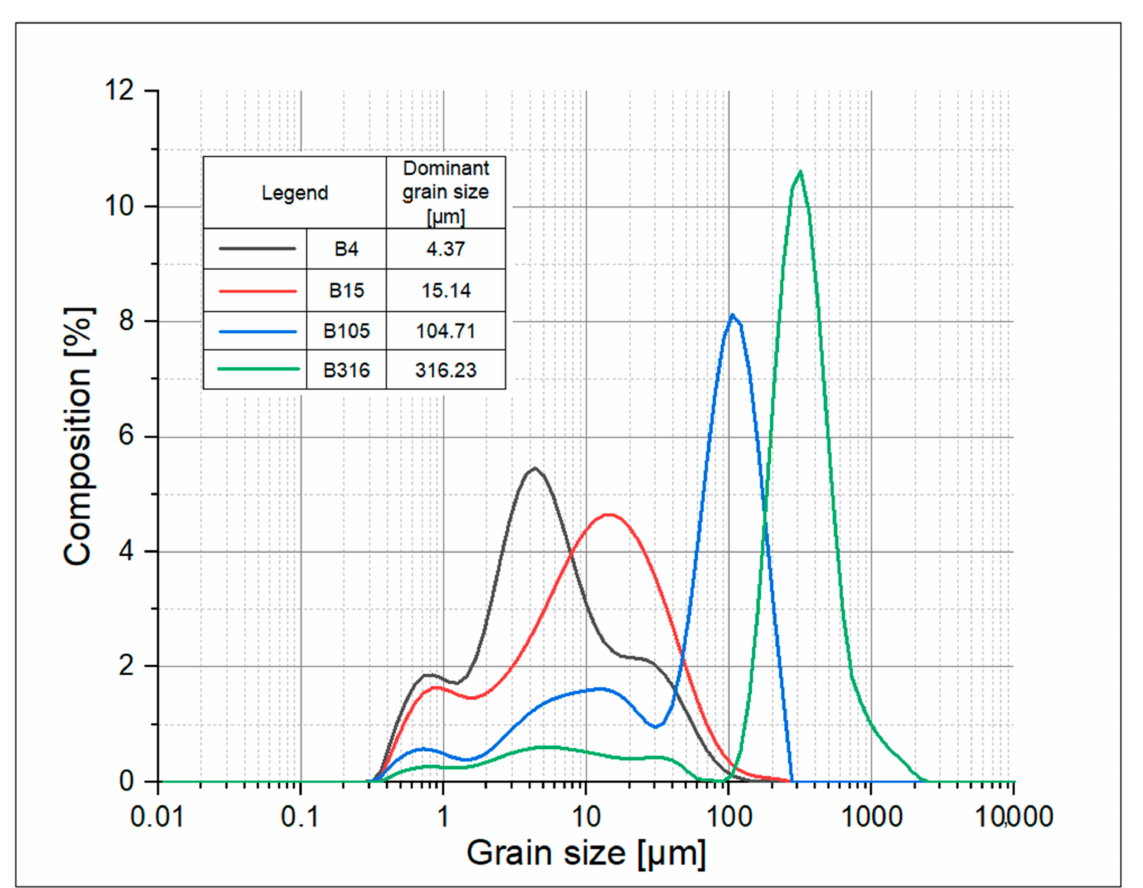
Figure 1. Grain size distribution of limestone from Bukowa deposit in four different grain sizes: B4, B15, B105 and B316.